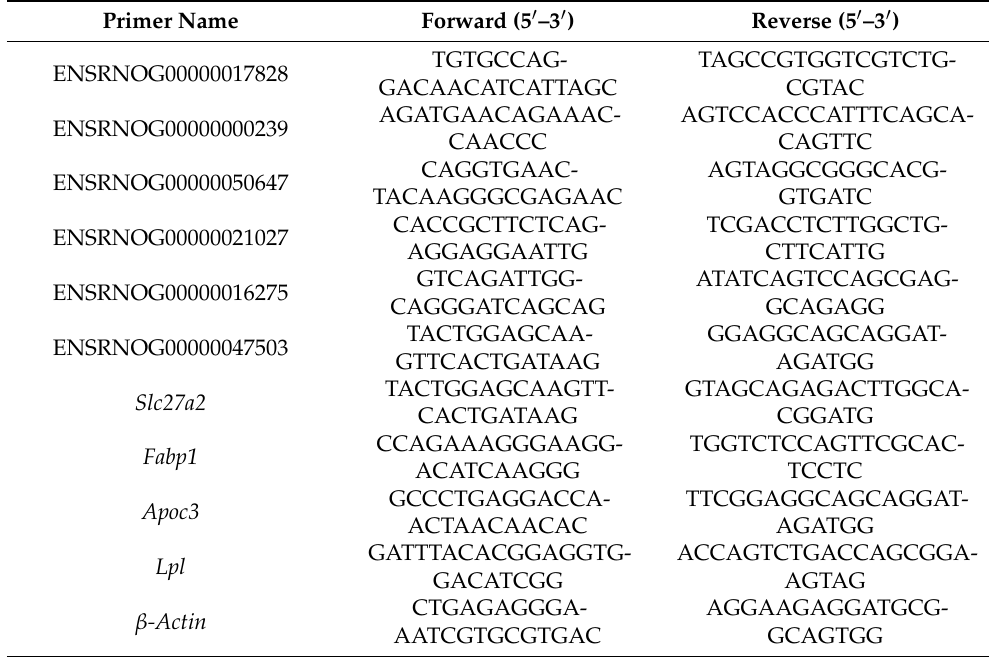
Table 2. Primer sequences.